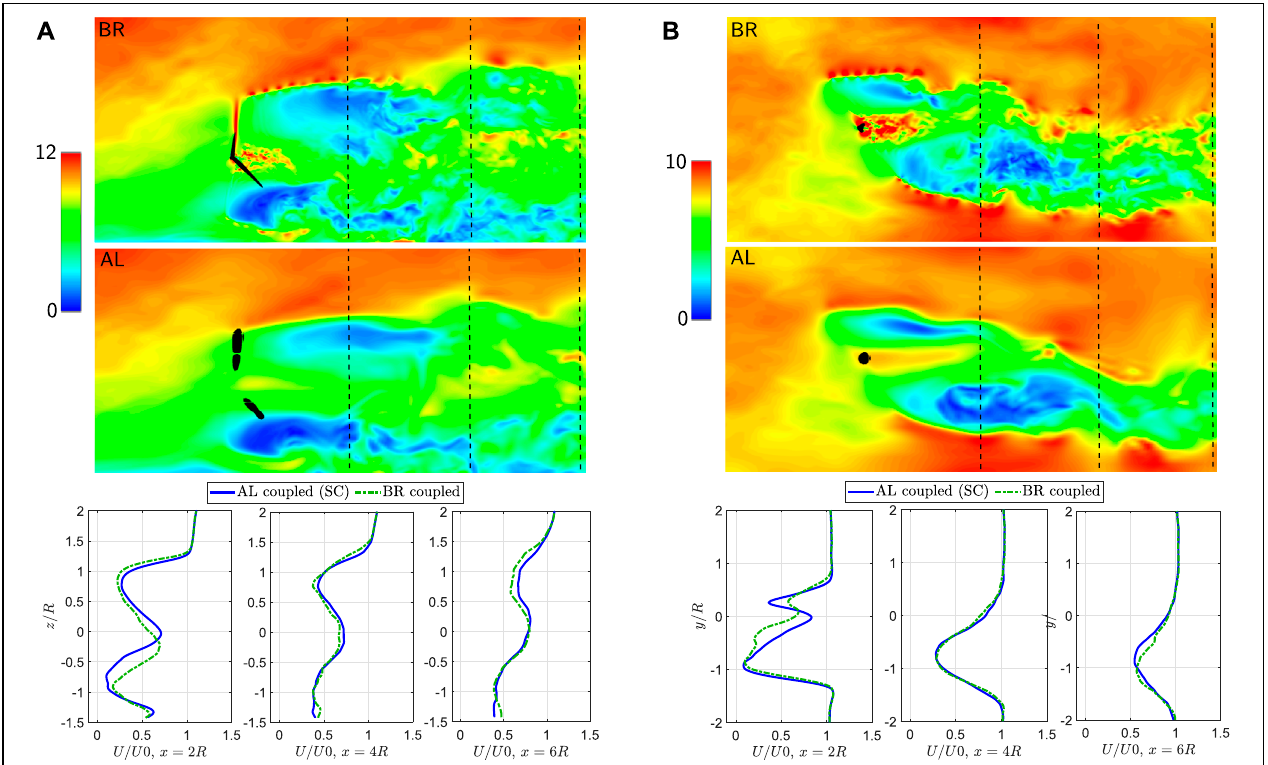
FIGURE 11 | Case 5: High shear, high yaw and turbulence. Instantaneous velocity magnitude at centreline planes and mean velocity plots at marked locations. Blades shown by surface mesh for BR, and iso-surface of applied body force for AL. (A) Vertical plane and vertical mean velocity profiles. (B) Horizontal plane and horizontal mean velocity